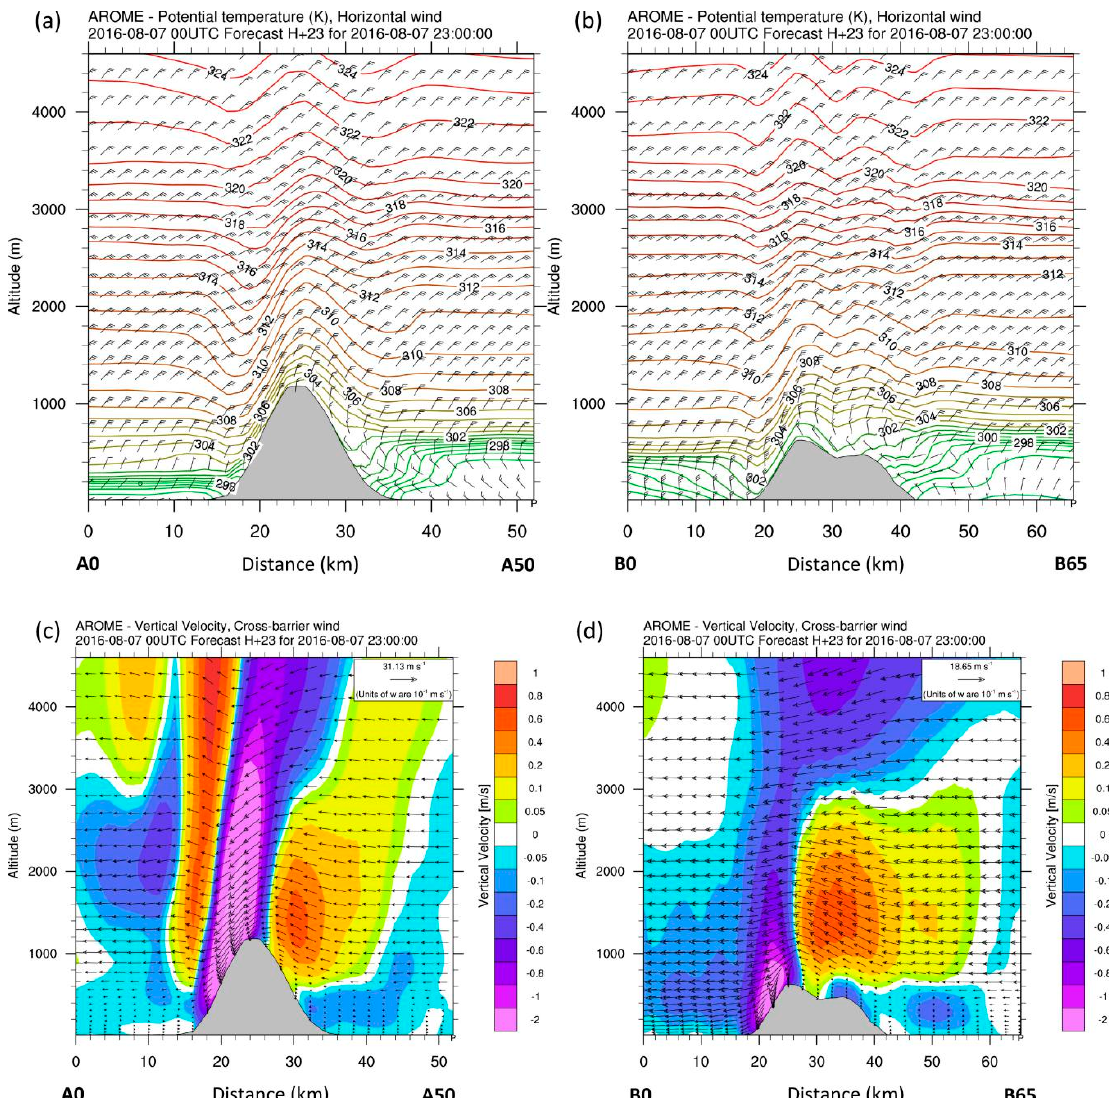
Figure 12. AROME vertical cross-sections at 23 UTC on 7 august 2016, along the horizontal axis A50-A0 ( a,c ) and B65-B0 ( b,d ). (a) and (b) Potential temperature (Isentropes interval is 1K) and horizontal wind (kt). (c) and (d) vertical velocity (w) and cross-barrier wind. Shading represents w in m s − 1 , positive values indicate upward vertical wind and negative values represent downward vertical wind. The locations of lines A50-A0 and B65-B0 are depicted respectively in Figure 1a,b. On the left panel, the distance of 14 km corresponds to the Funchal location. On the right panel, the distance of 20 km corresponds to the MIA location. The cross-barrier wind (w, v c ) is represented in arrows, where v c is the horizontal wind parallel to the cross-section.